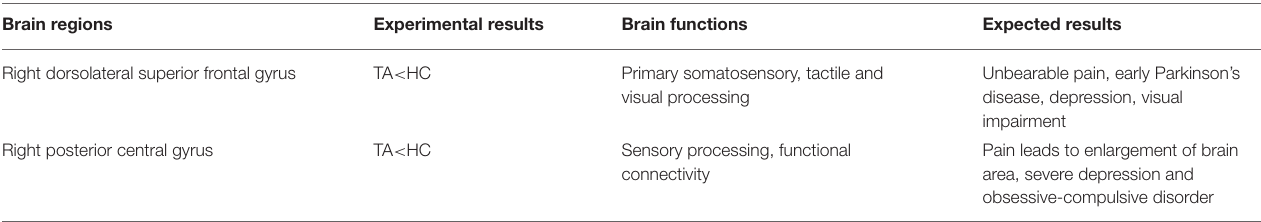
TABLE 4 | Brain regions and potential effects. Brain